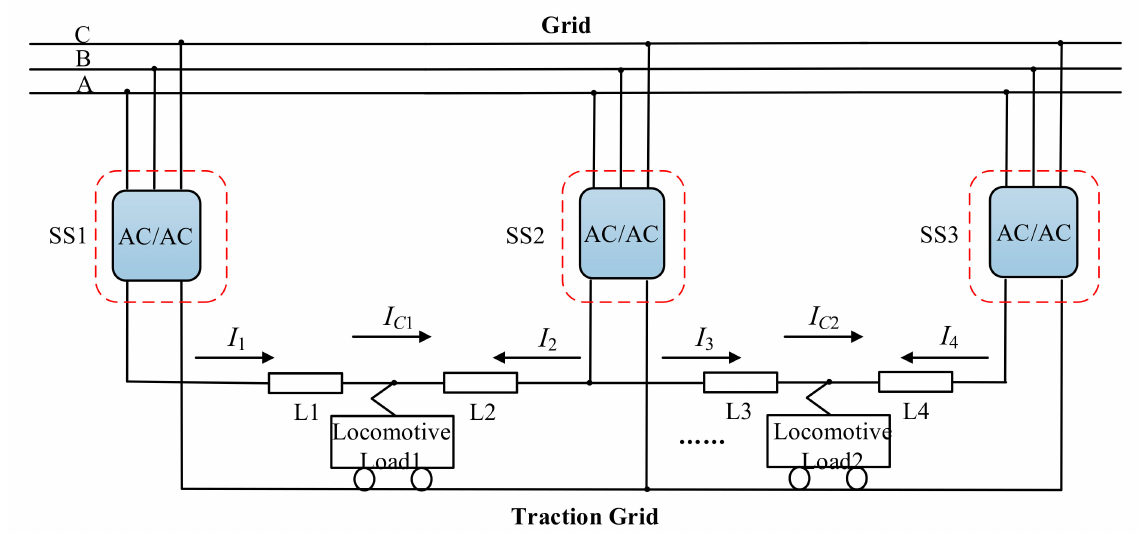
Figure 4. The structure of the traction microgrid system for the simulation model.